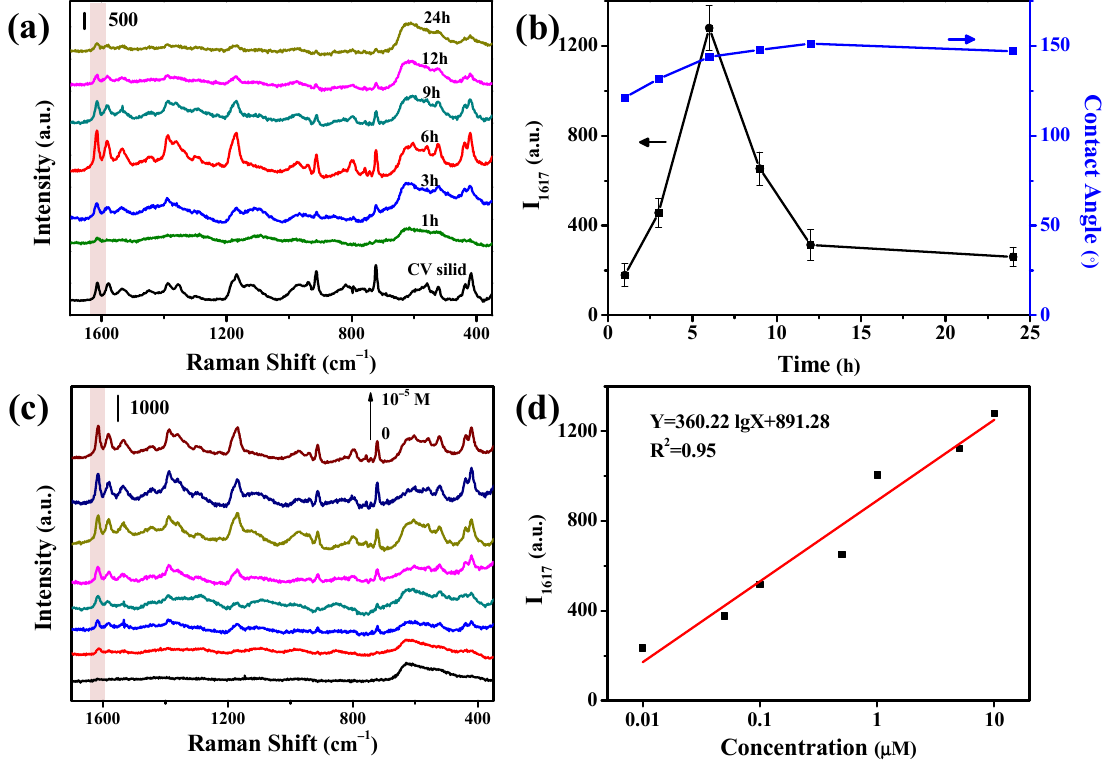
Figure 3. SERS performances of the Cu chip. ( a ) SERS spectra of 1 ppm CV on the Cu chips prepared with the different deposition time. ( b ) Influences of the Cu deposition time on the peak intensity of CV at 1617 cm − 1 and the contact angle of the chip surface. ( c ) SERS spectra of CV at various concentrations on the Cu chips. ( d ) A plot of the peak intensity of CV at 1617 cm − 1 against CV concentration.